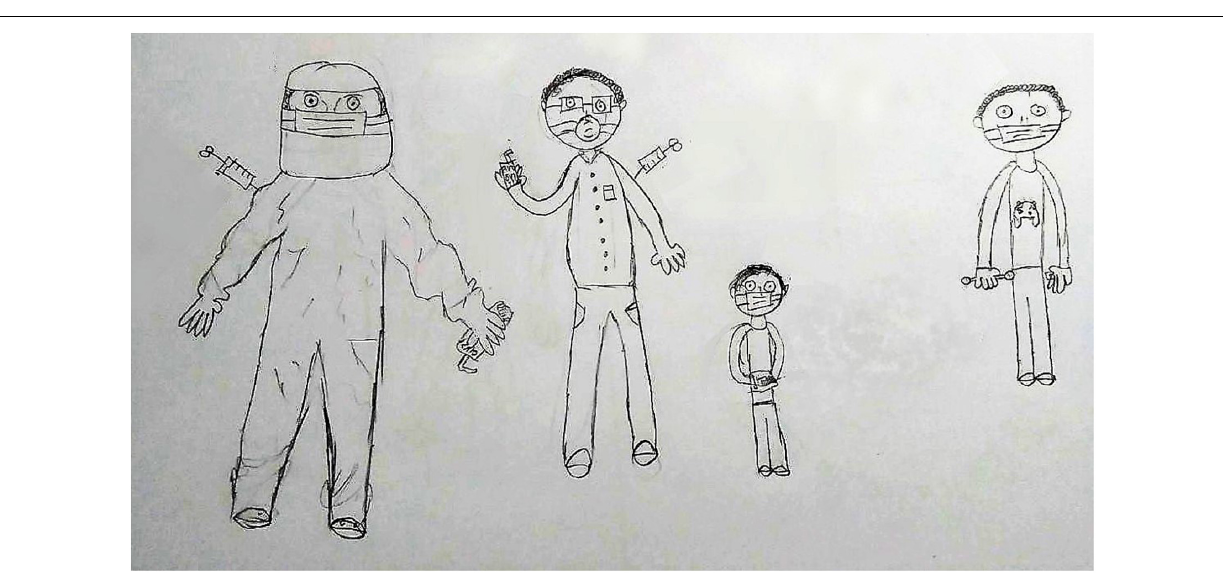
FIGURE 7 | A 10-year-old girl’s drawing of her family taking preventive measures: masks, hospital uniform, vaccines, antiseptics, and